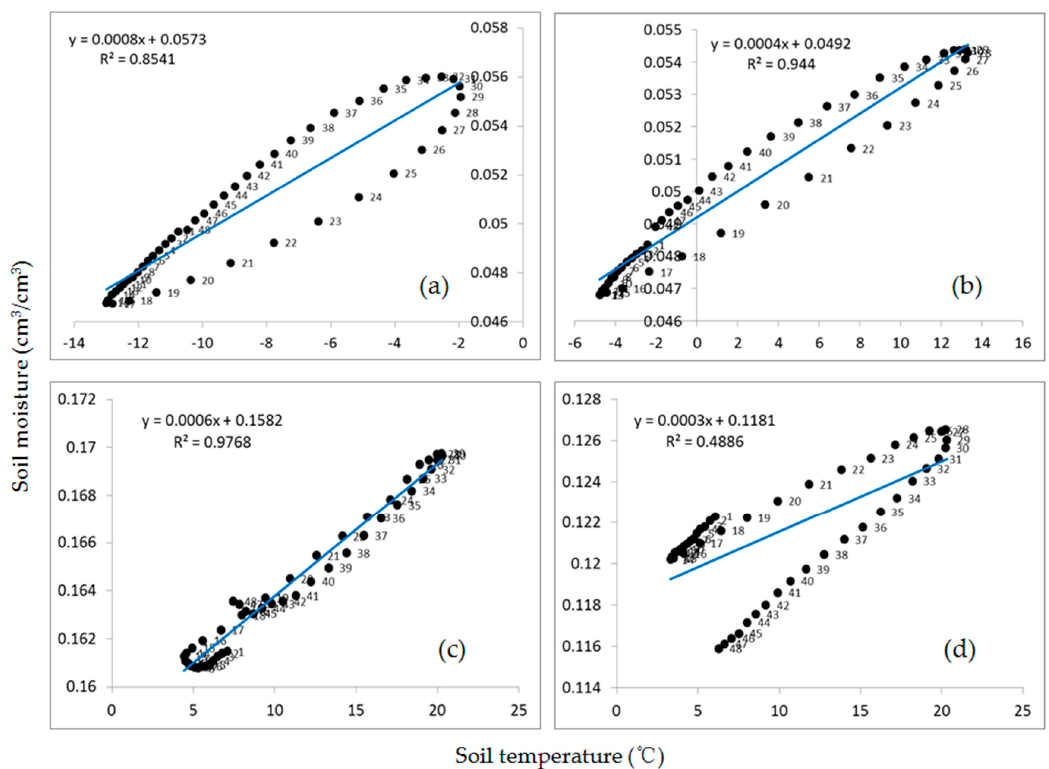
Figure 7. Scatter diagrams and linear fitting lines of diurnal variation of soil temperature and moisture at 5 cm deep at Amdo station. (The solid blue lines are the linear fitting line and the numbers next to the black dots represent the time sequence, the data interval is 30 min, from 00:00 to 23:30; there are 48 numbers in total.) ( a ) Winter (December–February), ( b ) Spring (March–May), ( c ) Summer (June–August) and ( d ) Autumn (September).